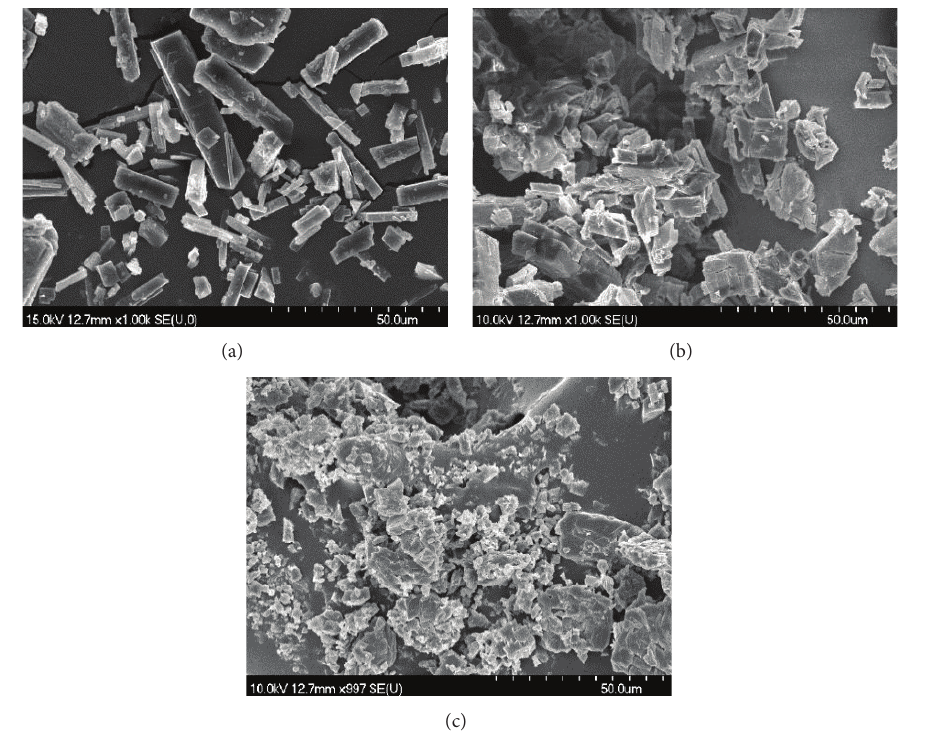
Figure 2: SEM pictures for (a) GEN, clear paralelipipedic crystals, (b) GMAE, irregular shaped crystals, and (c) GMAE-BCD, amorphous product indicating the formation of a distinct new product as a result of the intermolecular interaction.